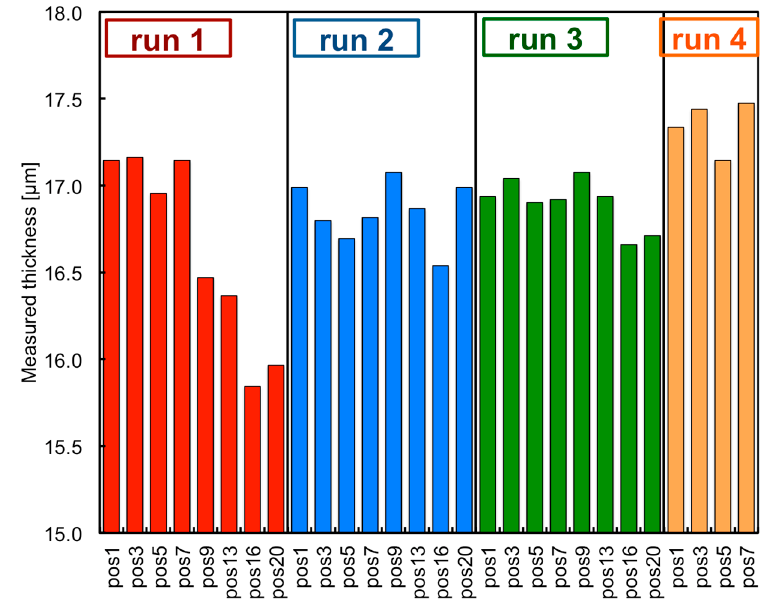
Figure 12. The measured thicknesses for the 28 samples.